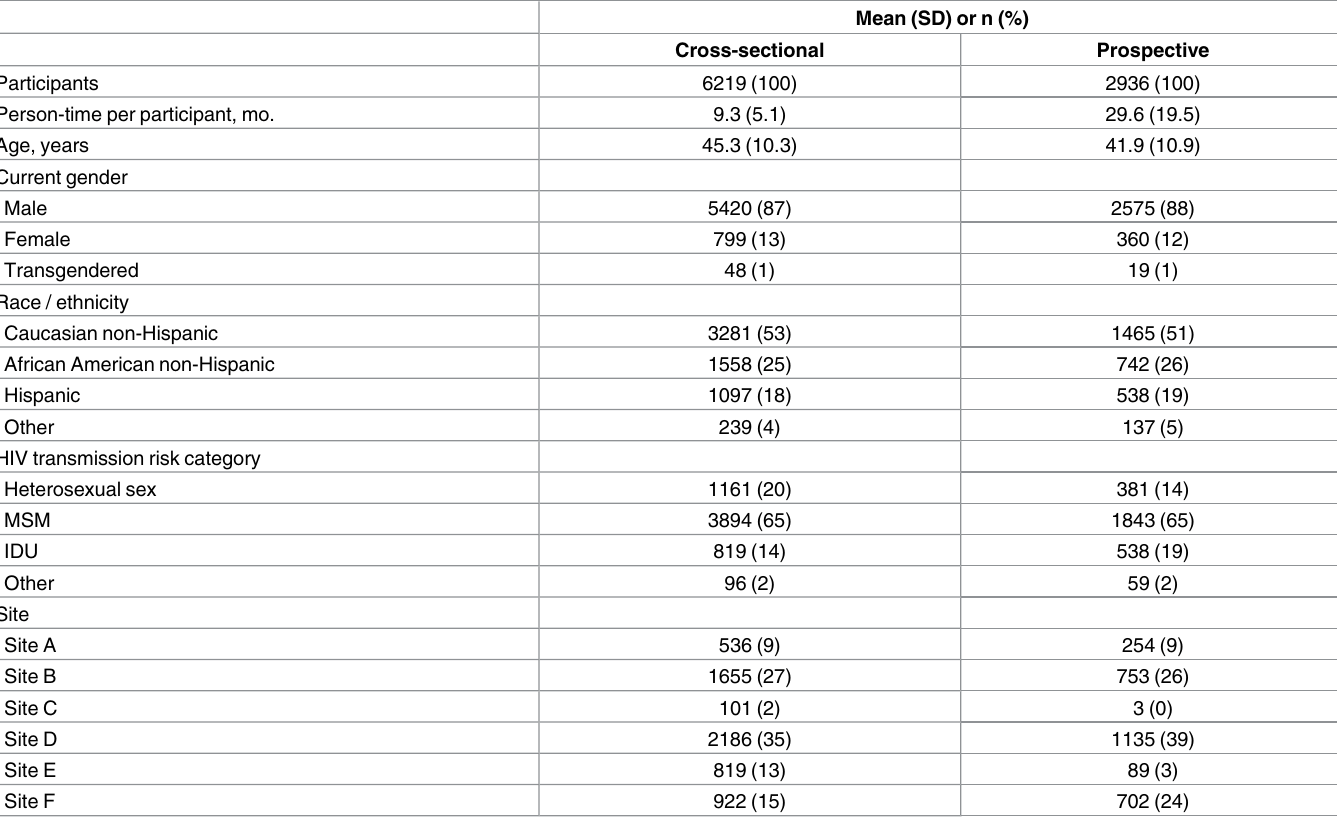
Table 1. Description of sample.